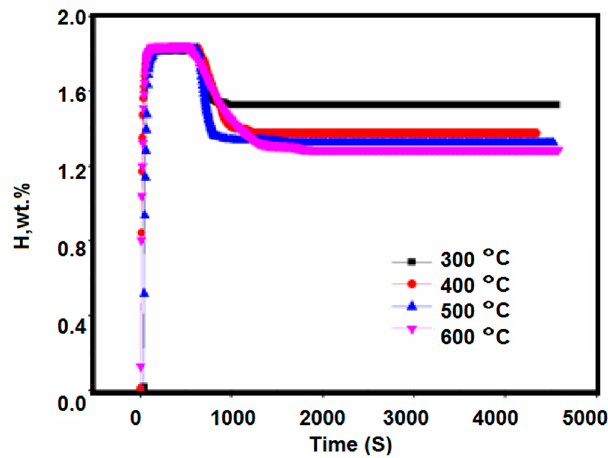
Figure 7. Disproportionation reaction curves of Zr 2 FeH 5 during 1 h hydrogen release at 300–600 °C.